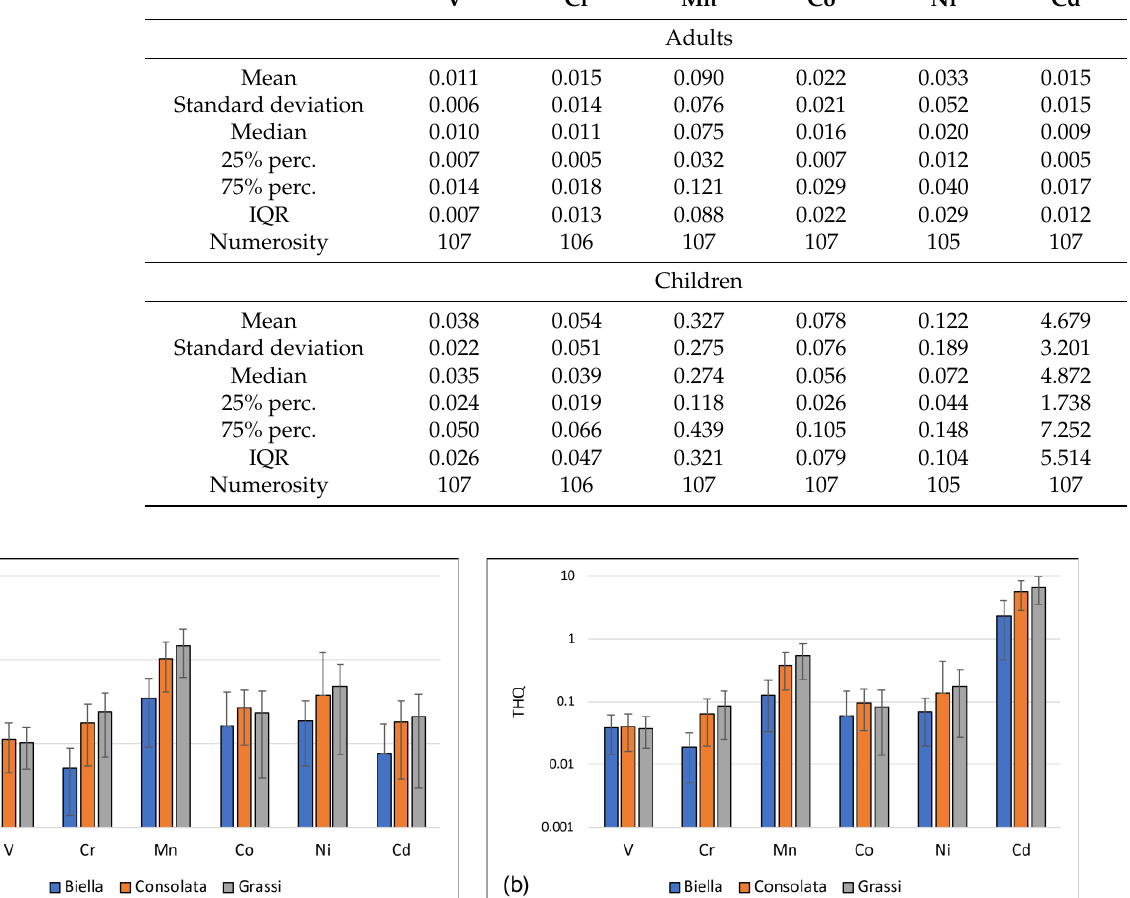
Table 6. Descriptive statistics of THQ values for adults and children.